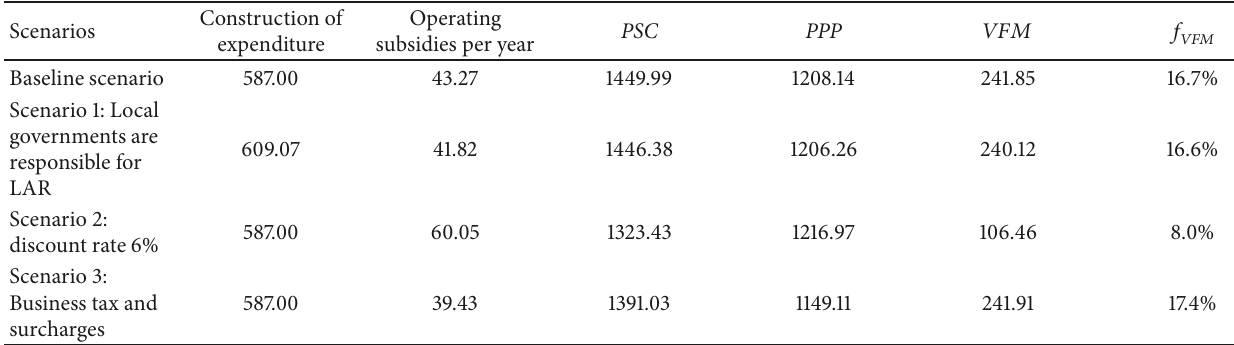
Table 8: VFM comparison under different scenarios, unit: million